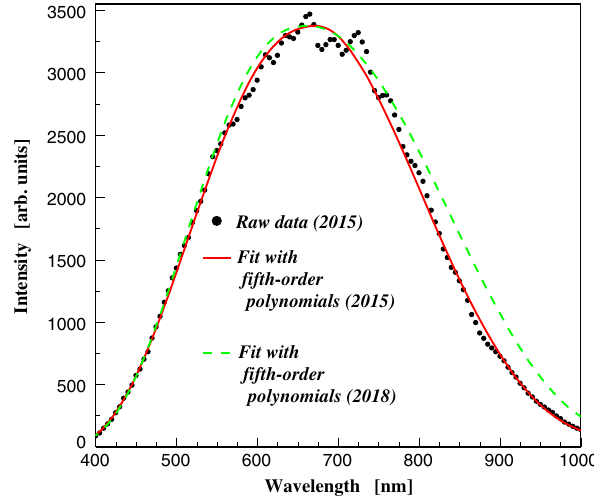
FIG. 9. Spectrum measurements for the uniform light emitted by the integrating sphere. The black dots are raw data taken in 2015 before the delivery of the hyperspectral camera. The solid red curve (dashed green curve) was obtained by fitting the raw data taken in 2015 (2018) with fifth-order polynomials for use as the reference spectrum. The height of the dashed green curve is scaled so that the two reference spectrum curves have the same